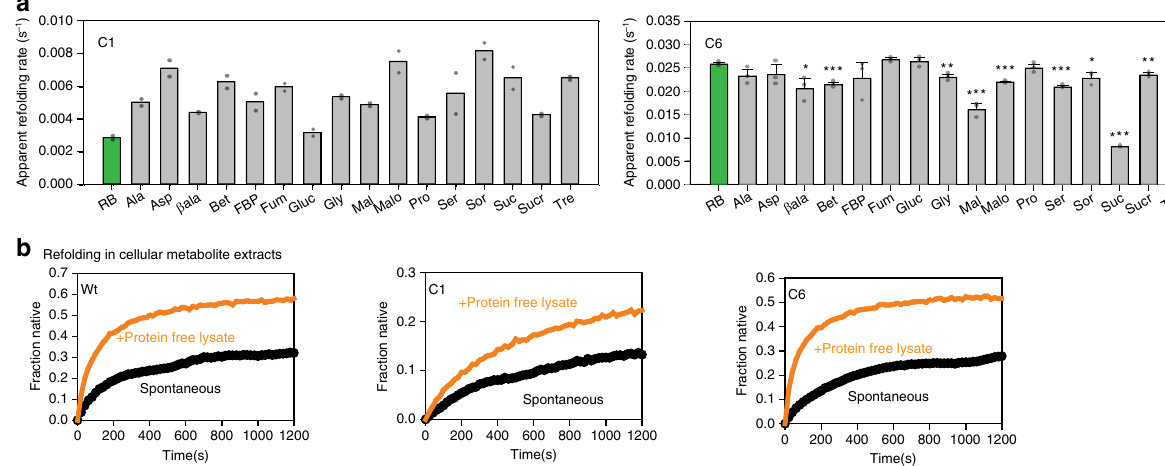
Fig. 6 Metabolites can chaperone the mutants in vivo and in vitro. a Refolding of Wt GFP or mutant GFP was initiated as described earlier in the presence of 100 mM concentration of different metabolites. Refolding rates were obtained by fi tting the refolding traces with single exponential equations. Mean of refolding rates from two replicates for C1 and three replicates for C6 along with standard deviation as error bars. RB (shown in green bars) are refolding rates in Buffer-A, the base buffer in which the metabolites are added. p -value is calculated using 2-sided Students ’ t -test with respect to RB (* p -value β ala :0.02, Sor: 0.02; ** p -value Gly: 0.006, Sucr: 0.005; *** p -value Mal: 0.0004, Bet: 0.0007, Malo:0.0002, Ser: 0.0001, Suc:0.0000005). Ala Alanine, Asp Aspartate, β ala β alanine, Bet Betaine, FBP Fructose-1,6-bisphosphate, Fum Fumarate, Gluc Glucose, Gly Glycine, Mal Malate, Malo Malonate, Pro Proline, Ser Serine, Sor Sorbitol, Suc Succinate, Sucr Sucrose, Tre Trehalose. b Protein-free extracts were isolated from wild-type E. coli (BW25113, BW) as described in Methods. Refolding was performed by diluting unfolded proteins (Wt GFP or mutants) 100-fold into these extracts. Also see Supplementary Fig. 5 (Source data are provided as source data fi le Fig.